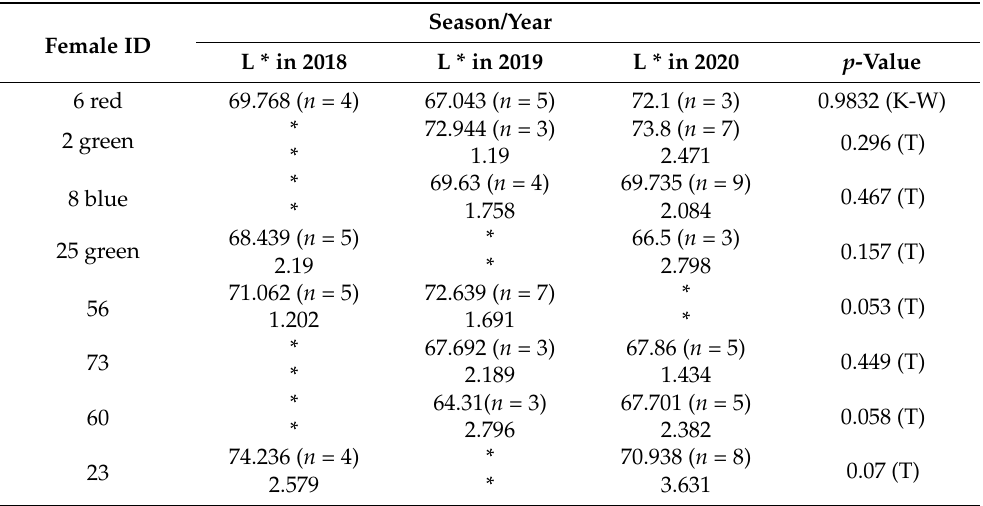
Table 1. Variation in eggshells lightness [L*] over the following seasons (2018, 2019, 2020) for the same females. K-W means performed test was Kruskall–Wallis, T performed test was t -test. The number of eggs ( n ) was given for each